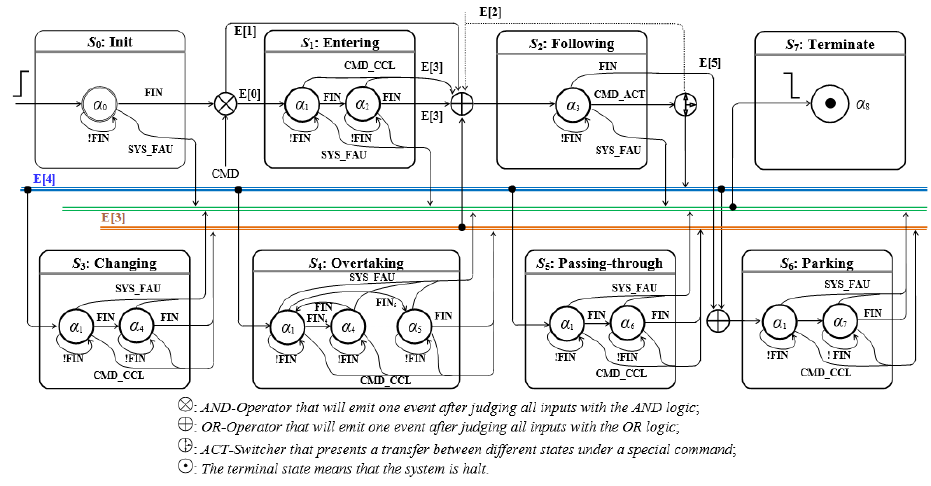
Figure 3. Event-triggered S-Automata A S